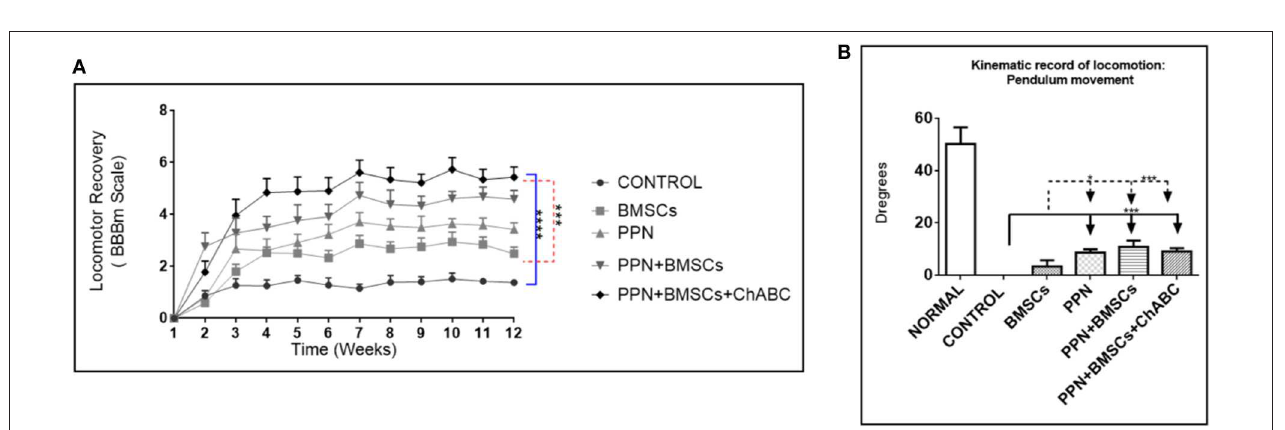
FIGURE 6 | Effect of therapeutic approaches on locomotor function. (A) Shows the modified BBB scores obtained during 12 weeks after treatment. Statistical analysis: repeated-measures ANOVA followed by Tukey test. **** p < 0.0001; *** p < 0.001. (B) Shows kinematic recording of pendular movement. Statistical analysis: two-way ANOVA followed by Tukey test. *** p < 0.0001; * p < 0.05. Data are expressed as the mean ± S.E.M. ( n =